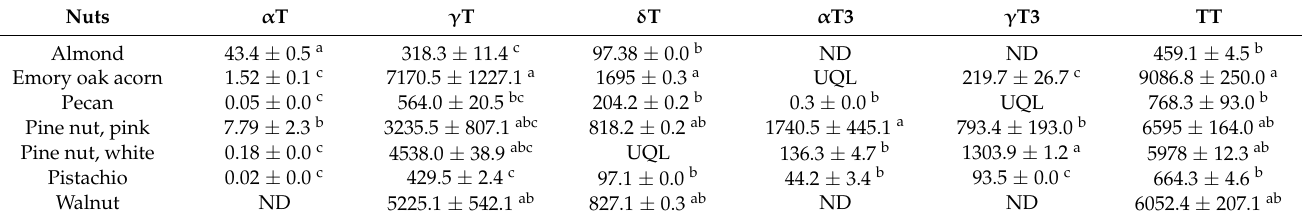
Table 2. Content of individual tocoferols (T) and tocotrienols (T3) in TRE extracts from nuts.